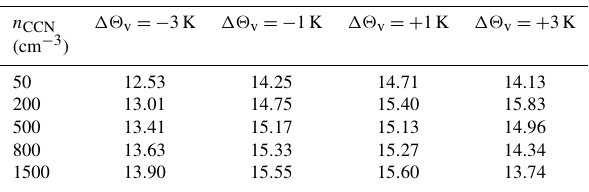
Table A2. Temperature sensitivity (in %K − 1 ) of accretion for all n CCN values.